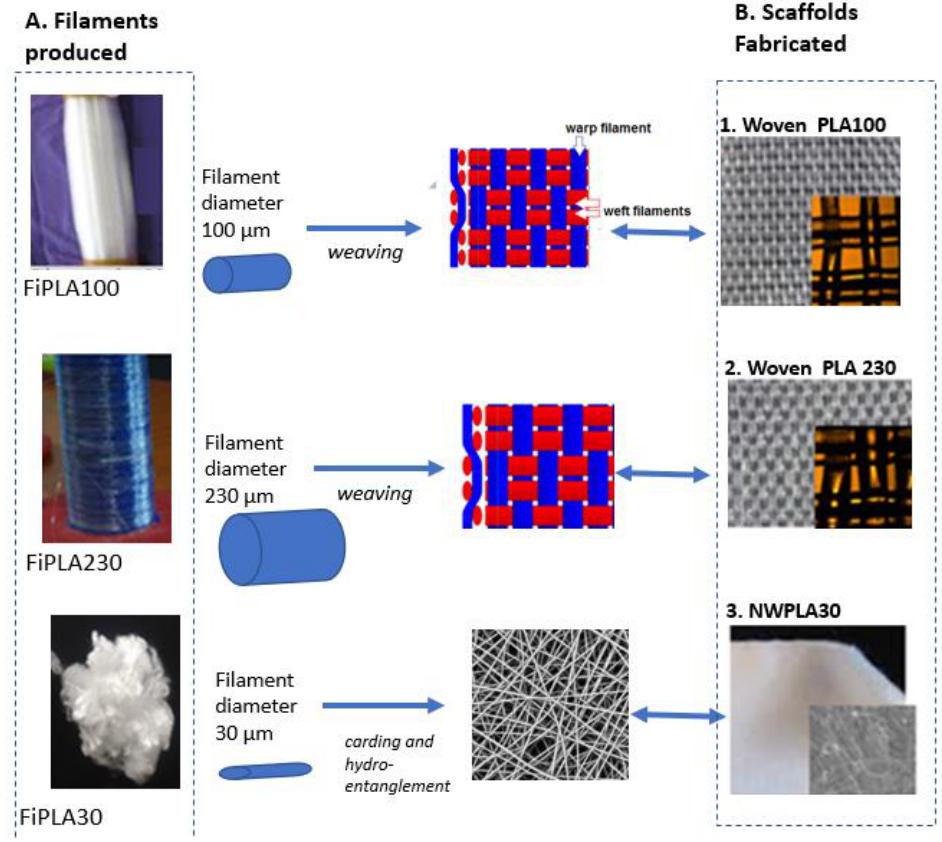
Figure 3. Morphological Analyses of PLLA filaments fabricated, and the fibrous PLLA scaffolds tested. ( A ). Photographs of the three different PLLA filaments of diameter 30, 100 and 230 µm; ( B ) Different scaffolds subjected to biological tests: two woven scaffolds WovenPLA100 and WovenPLA230 made from nanostructured PLLA filaments of 100 and 230 µm diameter, respectively, and a nonwoven scaffold NWPLA30 made from a smooth 30 µm diameter filament. In ( B ) on the front—pictures of scaffolds using binocular lenses are shown.